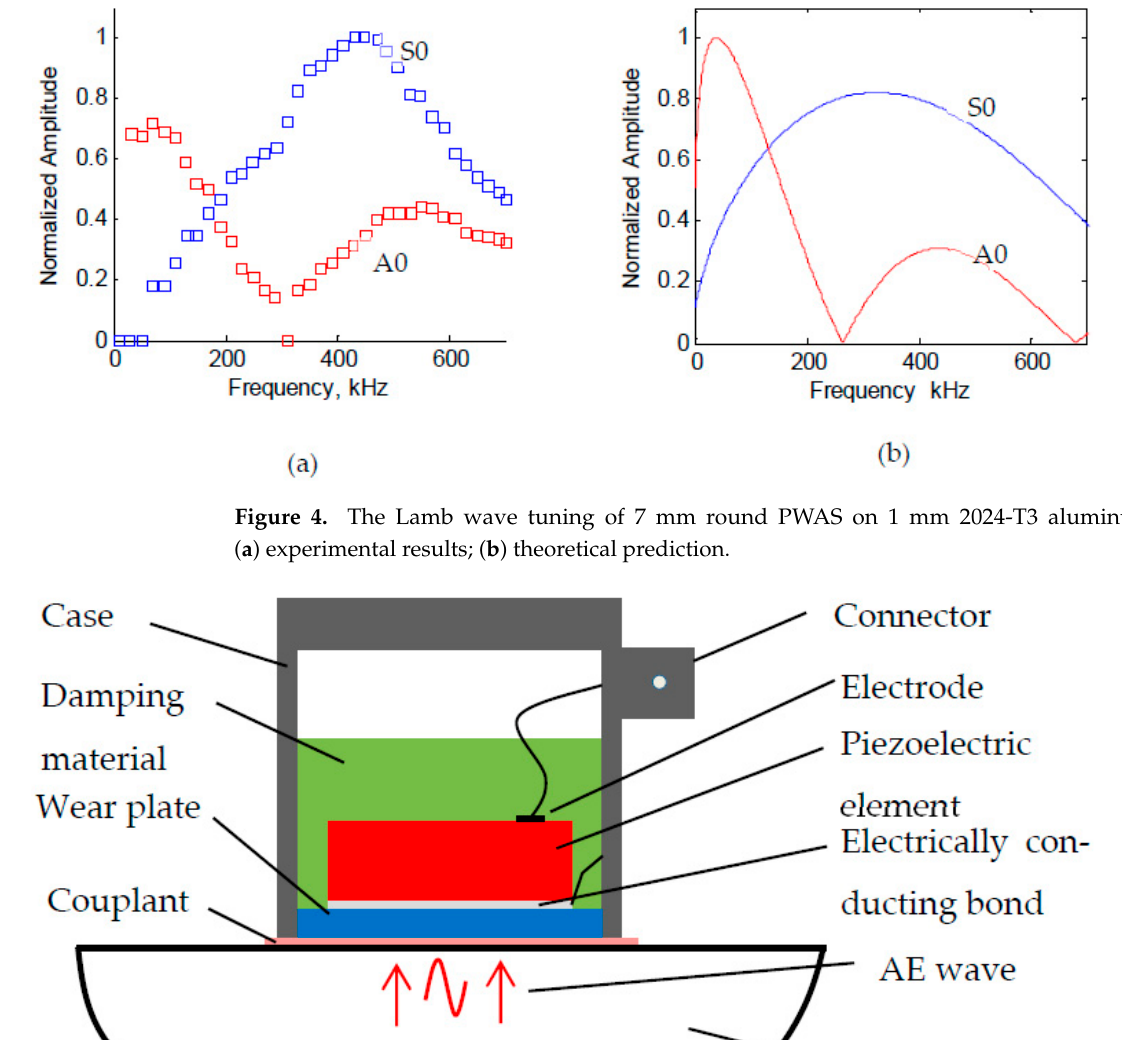
Figure 3. PWAS sensing mechanism. PWAS senses in-plane and out-of-plane wave motions through sensing in-plane strain.